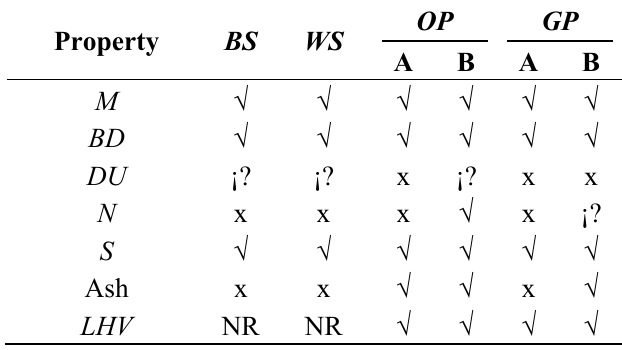
Table 7. Comparison with EN ISO 17225-6